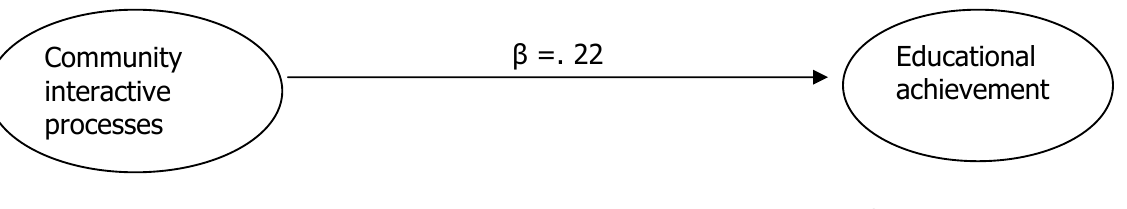
Direct effect of community interactive processed on educational achievement